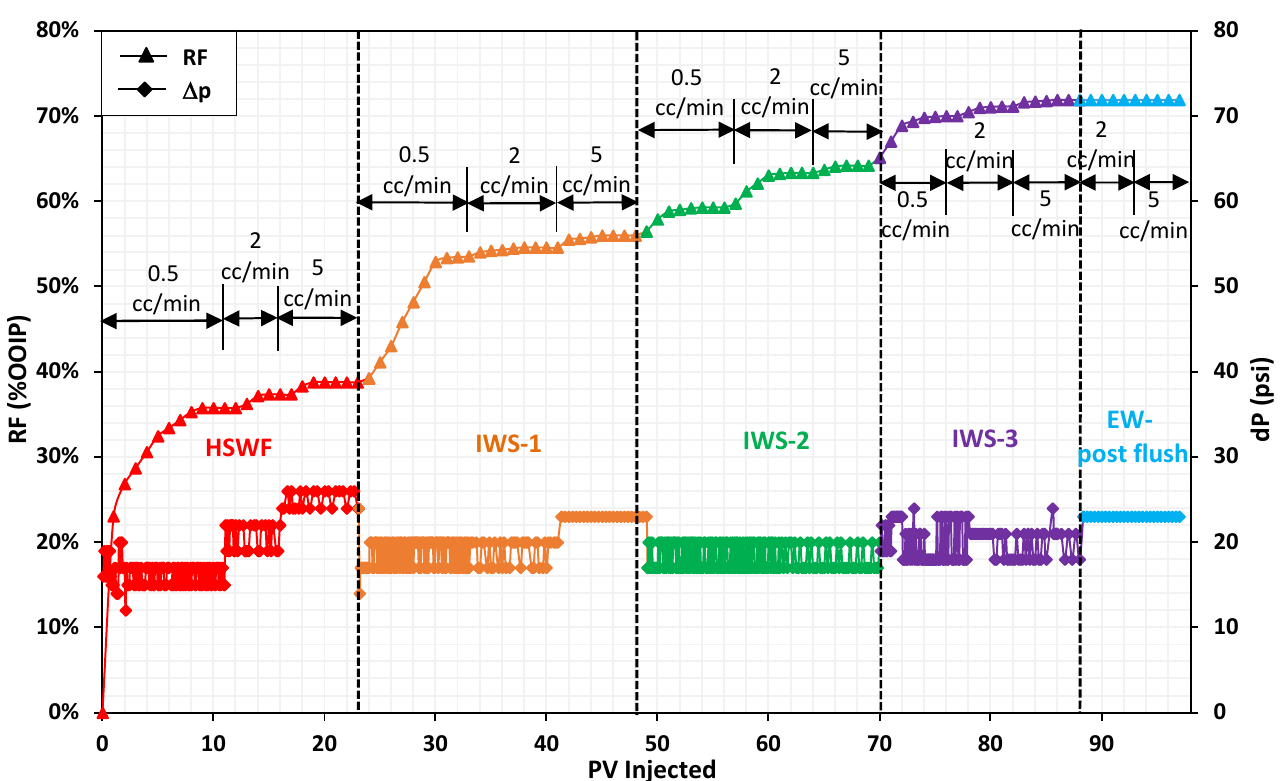
Figure 7. Pressure drop and oil recovery profile for CF-3 with a gradual negative salinity gradient.